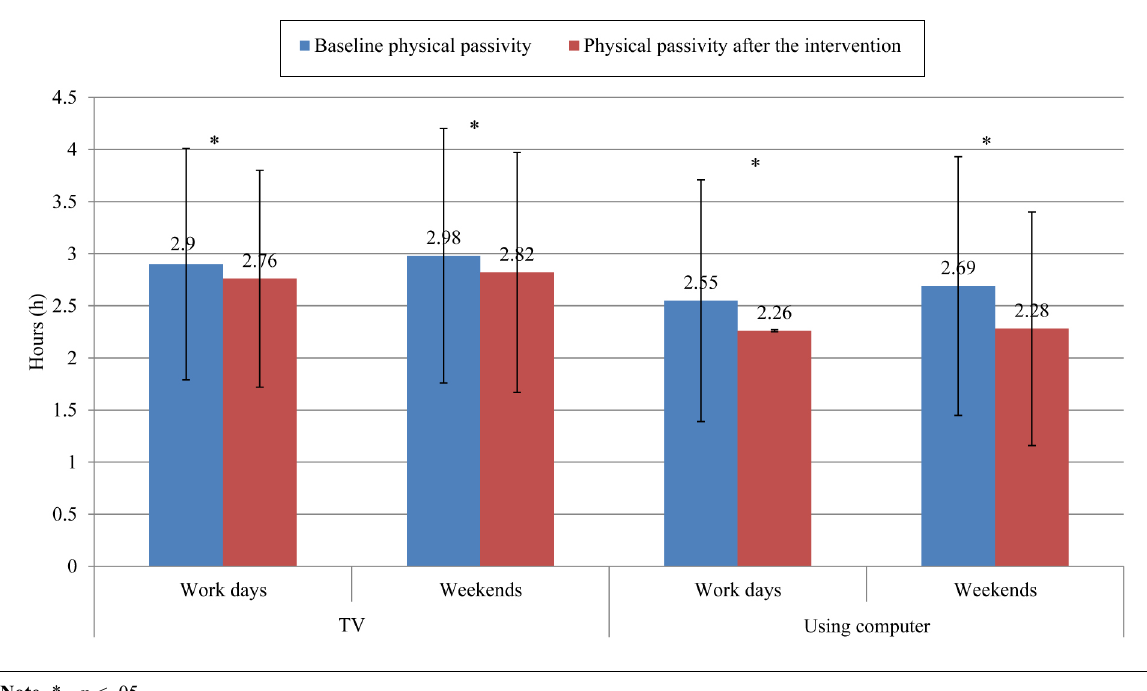
Note. * – p < Figure 6. Changes in the sedentary behaviour of the experimental group in three months’ intervention period